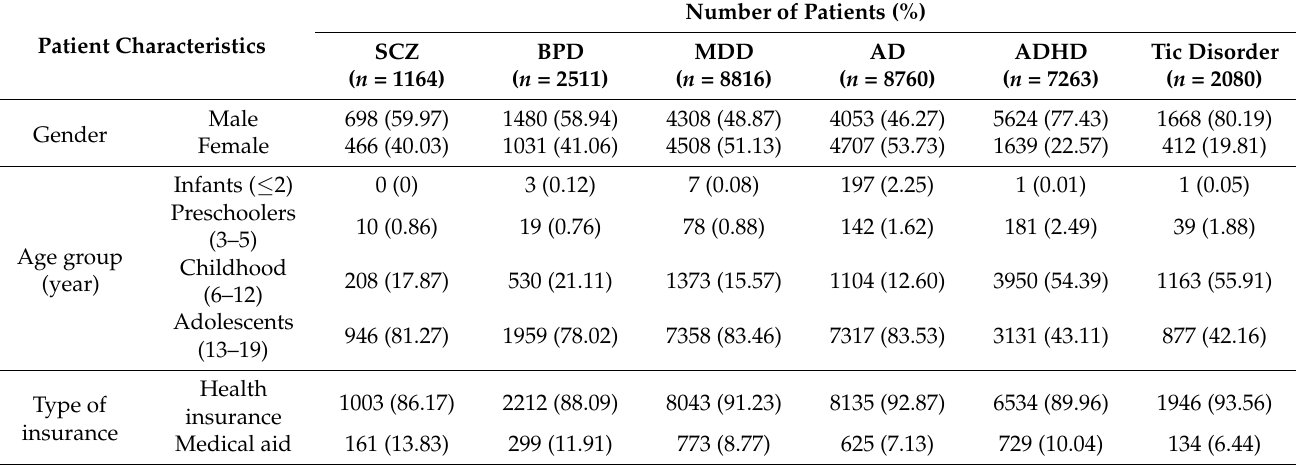
Table 3. Pediatric and adolescent patient characteristics by psychiatric disorder.